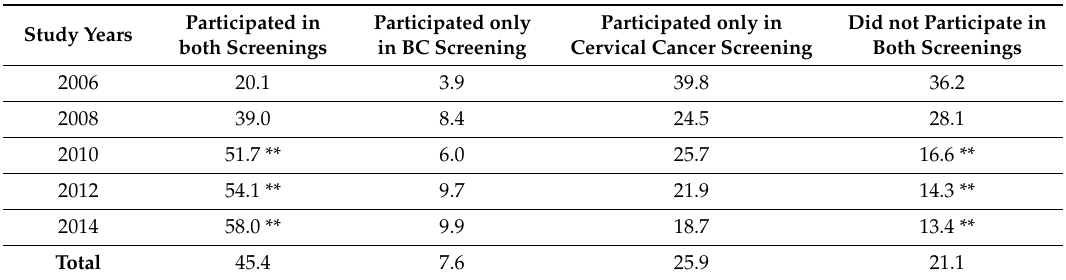
Table 2. Distribution of the respondents * according to participation in BC and cervical cancer screening in 2006–2014